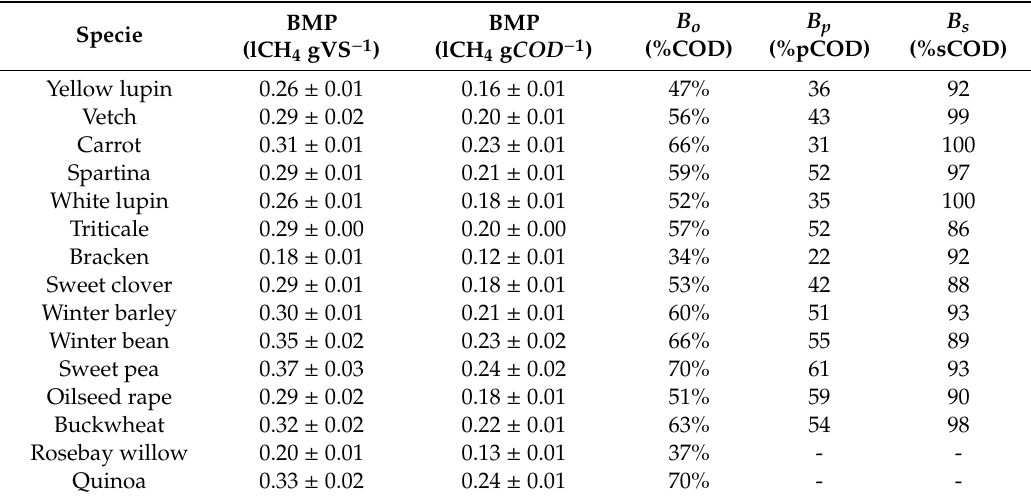
Table 2. BMP and biodegradability, as assessed from batch digestion of 15 European plant